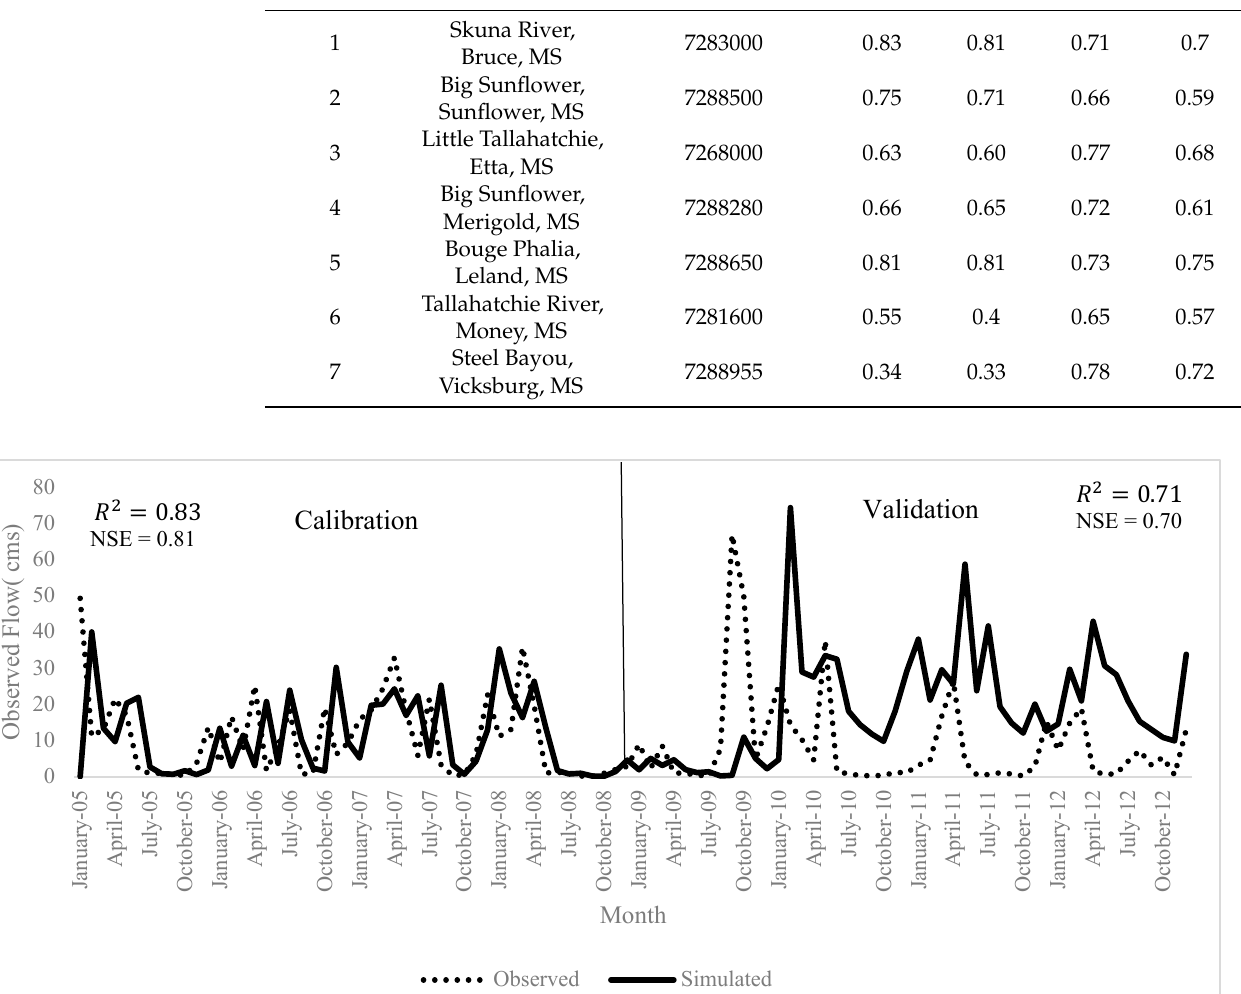
Figure 2. Streamflow calibration and validation trend at Skuna River gage (7283000), Bruce, MS, USA.